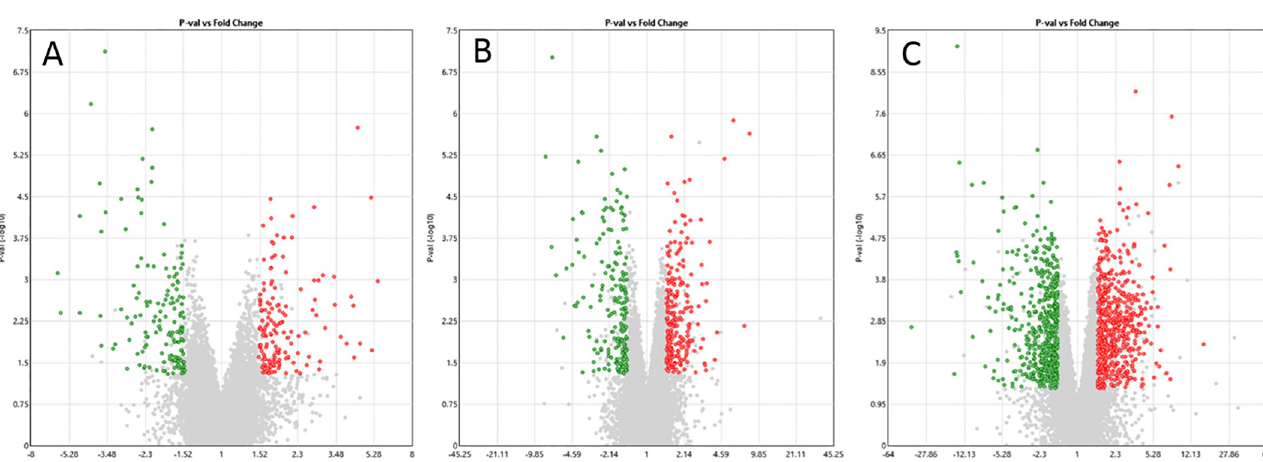
PLOS ONE | https://doi.org/10.1371/journal.pone.0221126 August 15,